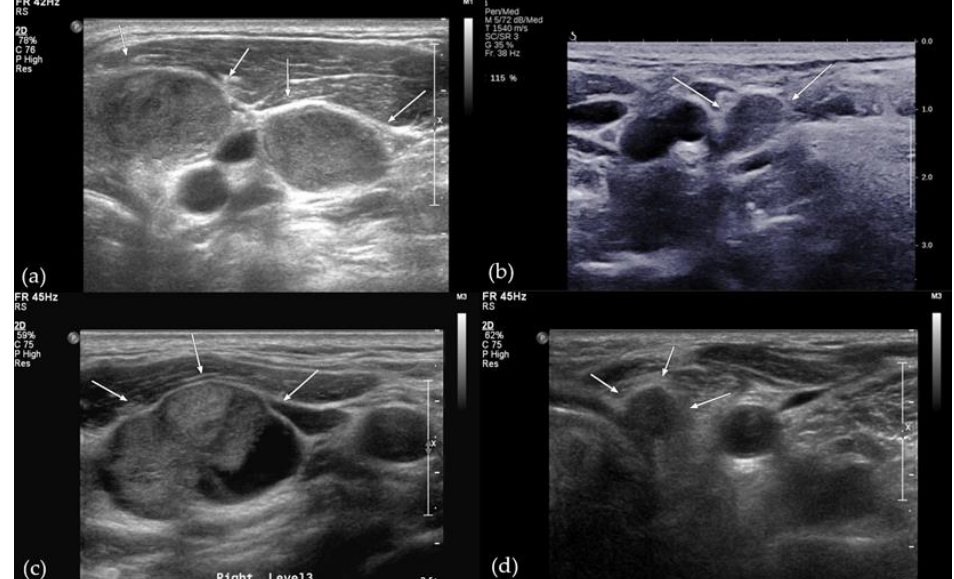
Figure 3. Ultrasound images showing diagnostic features of N1b papillary thyroid carcinoma. ( a ) Preoperative ultrasound image of a 24-year-old man showing hyperechoic metastatic lymph nodes on the left side of the neck at level III (arrows). ( b ) Follow-up ultrasound image taken 51 months after surgery, showing an 11-mm irregular, hyperechoic lymph node on the right side of the neck (arrows), which was a recurrence. ( c ) Preoperative ultrasound image of a 62-year-old man showing a 29-mm metastatic lymph node with hyperechogenicity and cystic change on the right side of the neck at level III (arrows). ( d ) Follow-up ultrasound image taken 48 months after surgery, showing an 8-mm irregular lymph node on the left side of the neck at level VI (arrows), which was confirmed to be a recurrence.